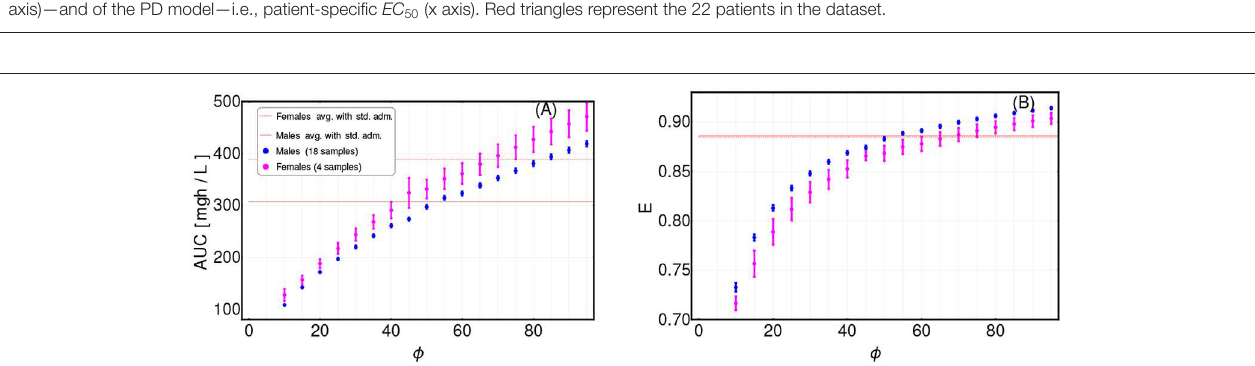
FIGURE 5 | Assessment of term weights in cost function definition. The definition of the cost function for the adjusting treatment scenario requires to set the weights of the different terms. We here considered two terms, in order to: (i) minimize the tumor burden (weight W 1 ), and (ii) minimize the AUC (weight W 2 ) (see section 3 for further details). We scanned the values of φ = W 1 in the range [10,100], by repeatedly applying the CT4TD framework to the 22-patients CML dataset from Michor W 2 et al. (2005) . (A) Distribution of the value of the AUC after 14-days of the optimized therapy retrieved by CT4TD (1-dose case), for distinct values of φ , with respect to the 22 samples in the datasets, divided in males (blue) and females (pink), and compared to the average AUC values returned by standard administration (400 mg Imatinib/day) in males (red solid line) and females (red dashed line). (B) Distribution of efficiency computed via Equation (10) on the time-average concentration over 14 days of the optimized therapy retrieved by CT4TD (1-dose case), for distinct values of φ , and compared to the average efficiency in the standard administration scenario (solid and dashed red lines